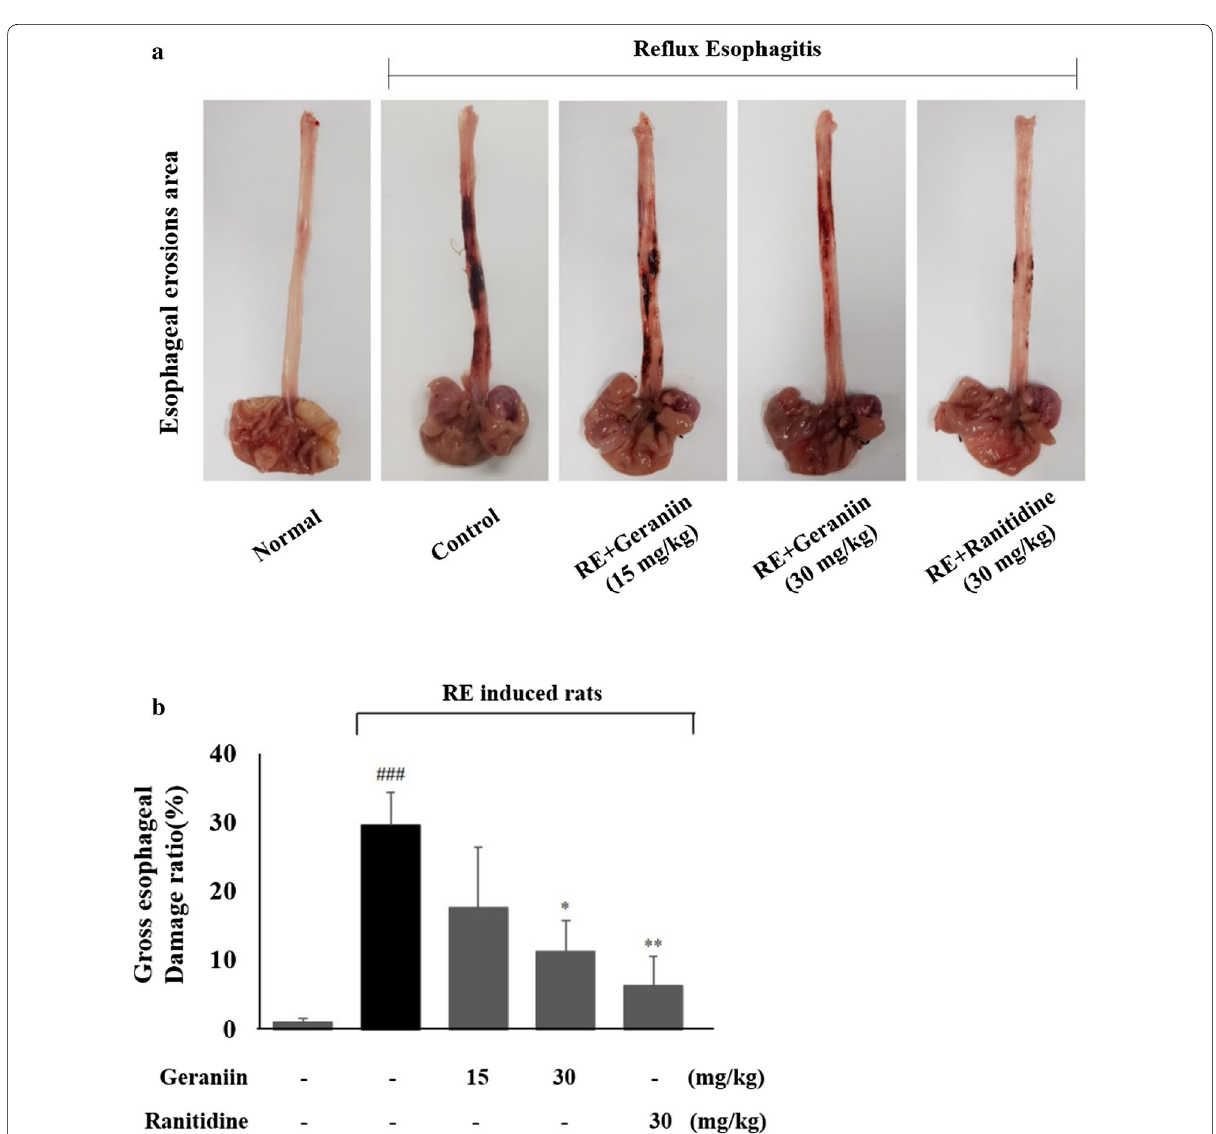
Fig. 3 Gross esophageal erosions area ( a ) and esophagus ulcer ratio ( b ) of RE rats. Normal, untreated rats; RE Control, RE rats; RE kg body weight treated RE rats; RE geraniin 30 mg/kg body weight treated RE rats; RE + mean standard deviation (SD); ## p < 0.01, ** p < 0.01, and * p < 0.05 compared with normal control and RE control groups, ±